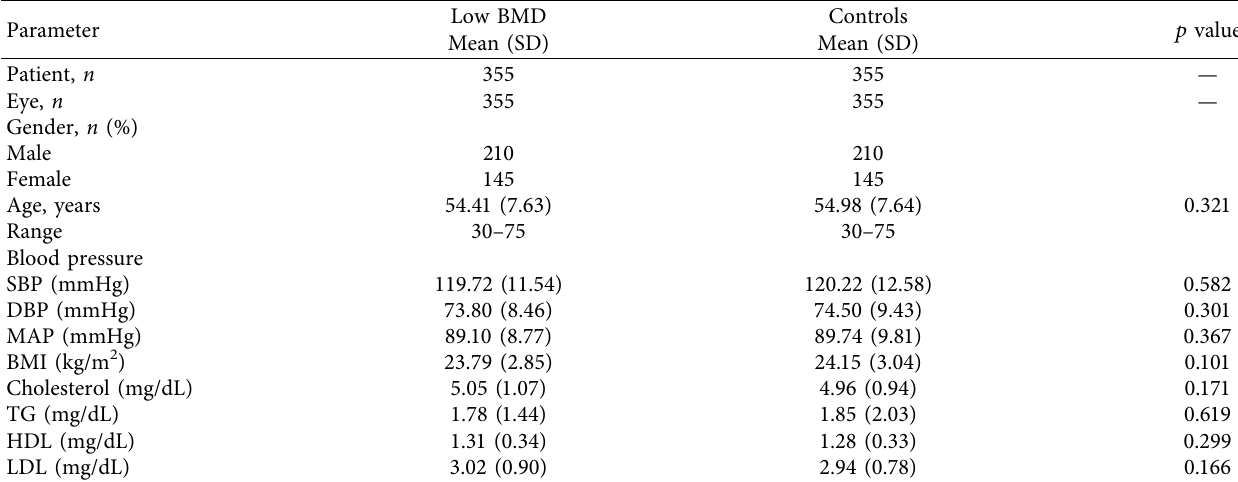
Figure 1: Representative images of choroidal thickness. (a) Choroidal thickness (between two green lines). (b) Choroidal thickness of nine sectors of the ETDRS grid. Table 1: Demographic and clinical features of the overall study